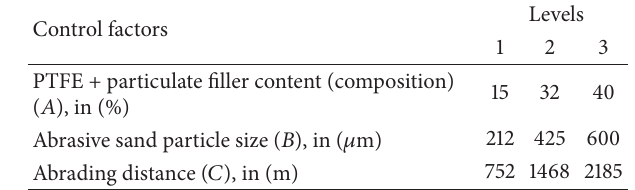
Table 3: Test parameters considered for three-body abrasive wear test.